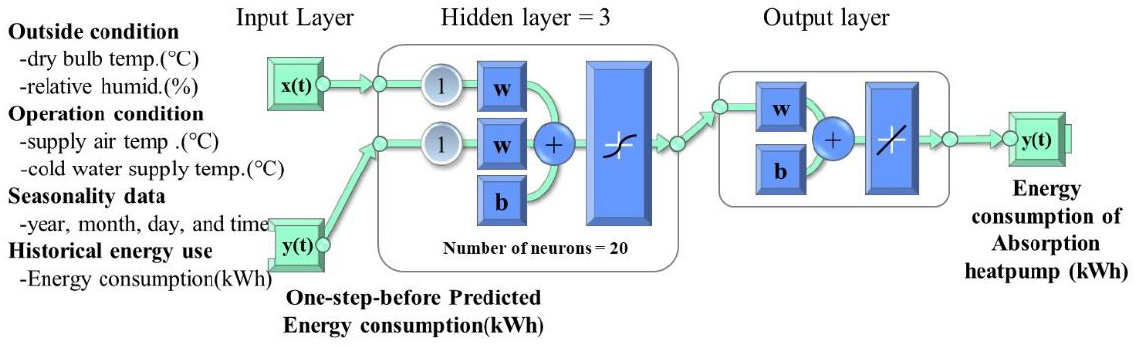
Table 1. Structural and learning parameters for multilayer shallow neural network training algo- rithms.